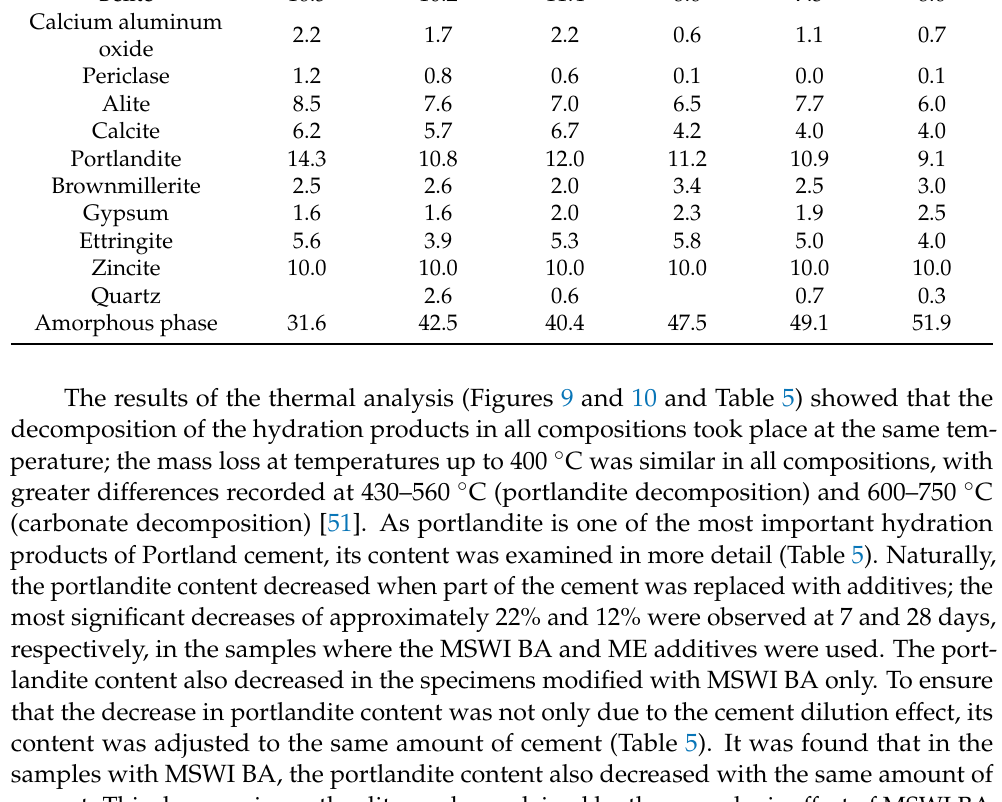
Figure 10. DTA and TG results after 28 days of curing.